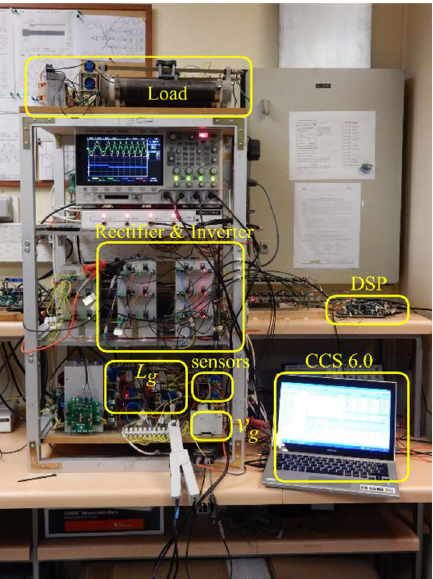
Figure 9. Experimental three-phase grid-connected power converter system.